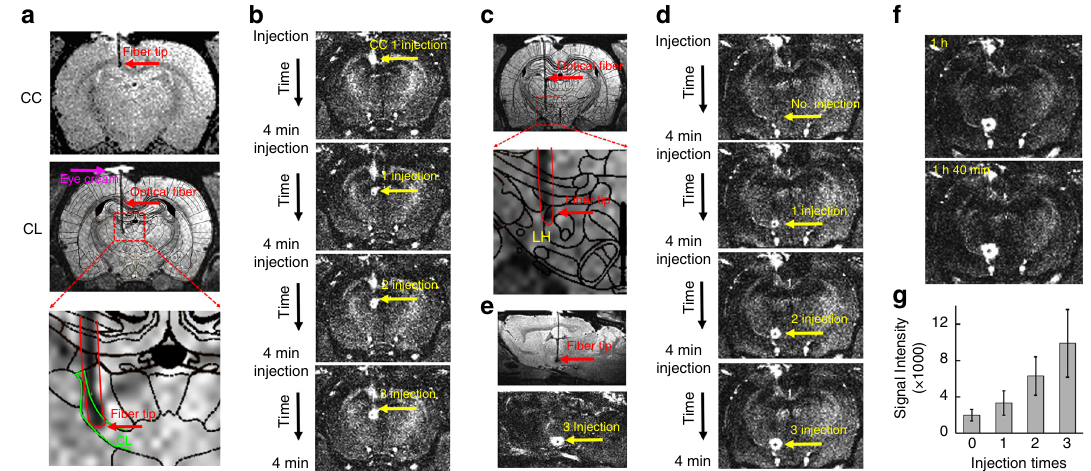
Fig. 5 MgRA-driven Mn-injection into CL and LH. a Top: the representative RARE anatomical image used to clarify the optical fi ber location driven by MgRA for Mn injection in CC. Middle: the atlas overlapped RARE images to illustrate the fi ber tip location at the CL. Eye cream is covering the craniotomy (magenta arrow). Bottom: enlarged image of fi ber location. b T1-weighted MPRAGE image (Mdeft) showing enhanced signal from Mn injection site in the CC and CL with dose-dependency. c Top: the atlas overlapped RARE images to illustrate the fi ber tip location at the LH, Bottom: enlarged image of fi ber location. d T1-weighted MPRAGE image showing enhanced signal from Mn injection site in the LH with dose-dependency. e Sagittal view of RARE anatomical image and MPRAGE image after MnCl 2 solution injection. f T1-weighted MPRAGE image at 1 h and 1 h 40 min after the injection. g The analysis of MEMRI signal at no injection, 1 injection, 2 injection, and 3 injection times, as shown in ( b , d ) ( n = 5 injection points from 3 animals). Error bars represent mean ±